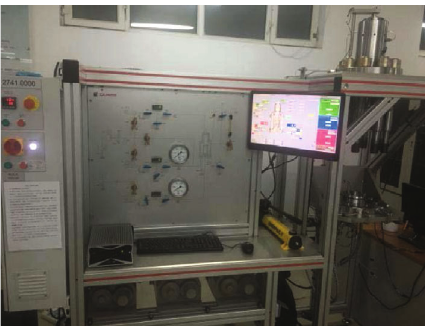
Figure 1: TOP INDUSTRIE Rock 600-50 automatic servo rock rheometer.